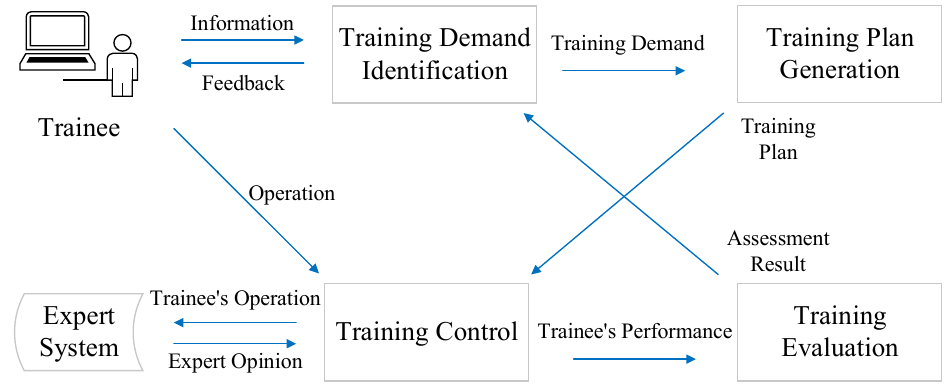
Figure 5. Intelligent training control subsystem.